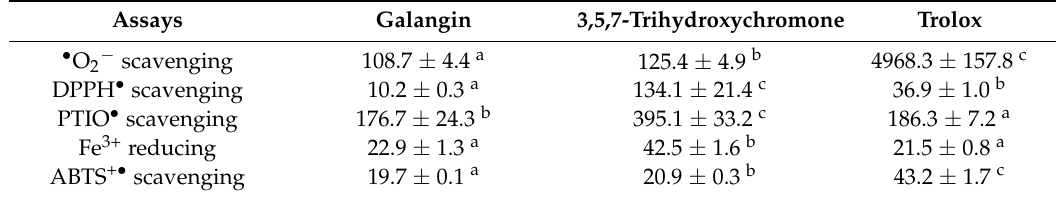
IC 50 values ( µ M) of galangin and 3,5,7-trihydroxychromone in five antioxidant spectrophotometer